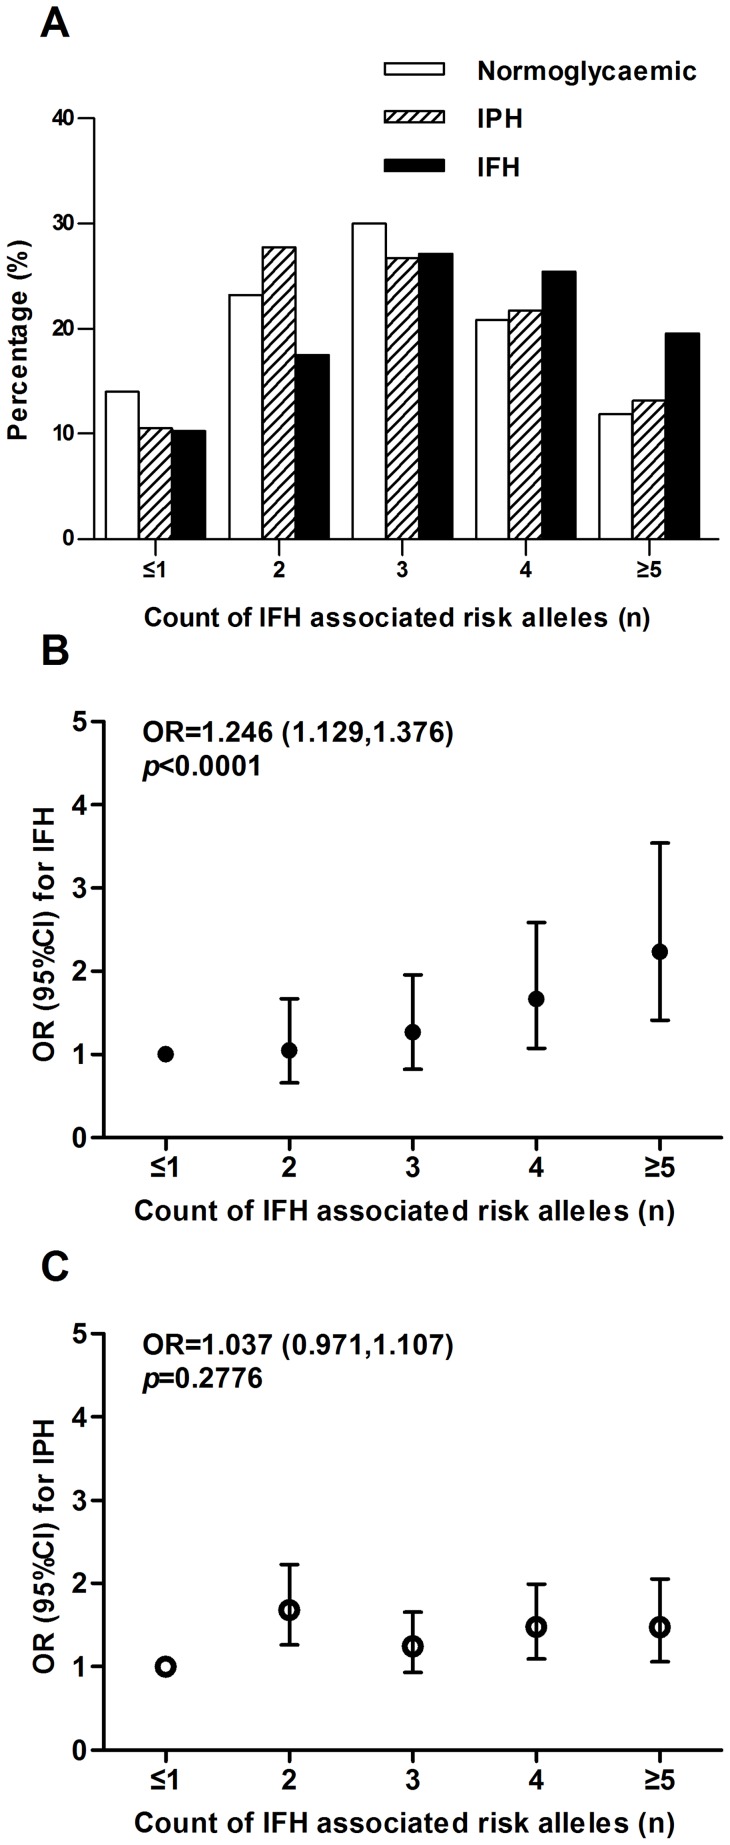
Combined effects of increasing numbers of isolated fasting hyperglycaemia-associated risk alleles for TCF7L2, CDKN2BAS, KCNQ1, FTO and GCKR.A: The isolated fasting hyperglycaemia-associated risk allele distribution in controls, participants with isolated fasting hyperglycaemia and isolated postprandial hyperglycaemia. Each additional risk allele increased the risk of isolated fasting hyperglycaemia by 1.24-fold (p<0.0001) (B) but not the risk of isolated postprandial hyperglycaemia (C). OR and 95% CI plotted on the y-axis for the corresponding number of risk alleles on the x-axis (black circles  =  risk of isolated fasting hyperglycaemia; white circles  =  risk of isolated postprandial hyperglycaemia). B: Participants harboring five or more risk alleles had a 2.23-fold increased risk for isolated fasting hyperglycaemia (p<0.0001) compared with the reference group. C: However, risk for isolated postprandial hyperglycaemia was not increased as risk allele number increased. IFH, isolated fasting hyperglycemia; IPH, isolated postprandial hyperglycemia.